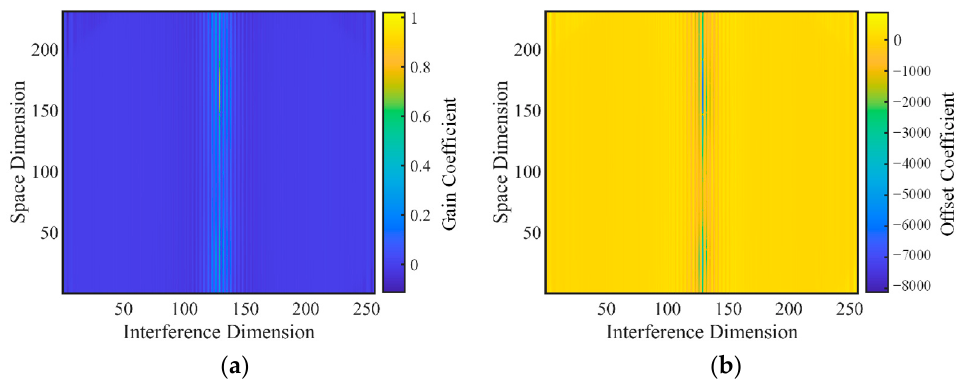
Figure 13. The calibration coefficient of the relative radiation response of each pixel. ( a ) Gain coefficient matrix. ( b ) Offset coefficient matrix.